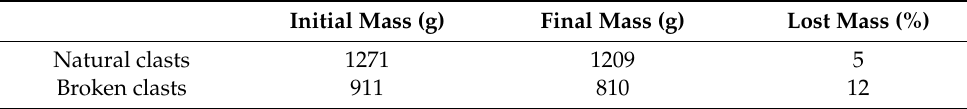
Table 2. Total mass loss after the experiment, for 50 natural and 50 intentionally broken